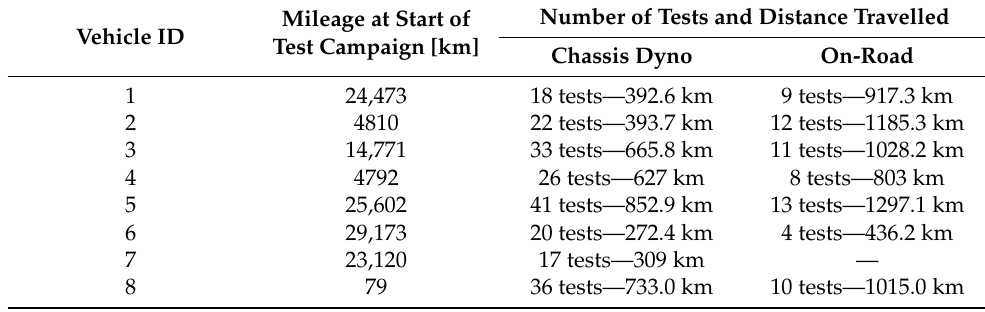
Table A1. Number of tests and corresponding distance travelled (including the preconditioning) on the chassis dynamometer and on the